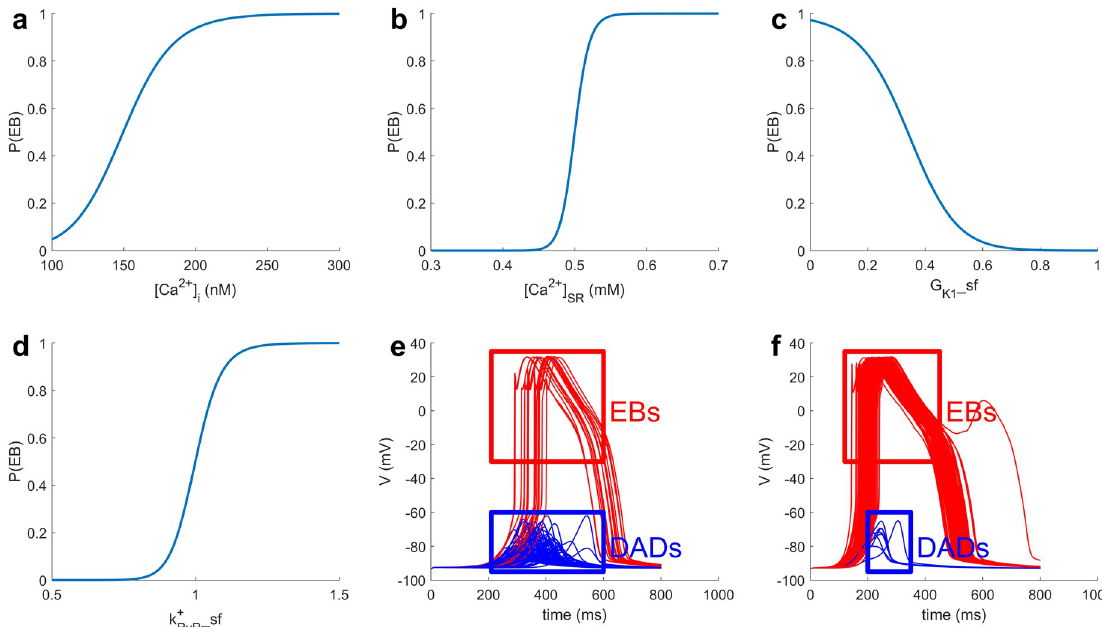
Fig 2. Relationship between MMIs and P(EB). In A-D, with exception of the MMI that is varied along the x-axis, MMIs are fixed at: [Ca 2 + ] iini = 150 nM, [Ca 2+ ] SRini = 0.5 mM, G RyR+ _sf = 1. (E) 100 random myocyte model simulations with a low P(EB) = K1 _sf = 0.338, and k 0.19; MMI set: [Ca 2+ ] iini = 216 nM, [Ca 2+ ] SRini = 0.47 mM, G K1 _sf = 0.699, and k RyR+ _sf = 1.12. (F) 100 random myocyte model simulations with a high P(EB) = 0.92; MMI set: [Ca 2+ ] iini = 154 nM, [Ca 2+ ] SRini = 0.60 mM, G K1 _sf = 0.775, and k RyR+ _sf = 1.03. Red curves represent EBs and blue curves represent DADs that do not trigger ectopic